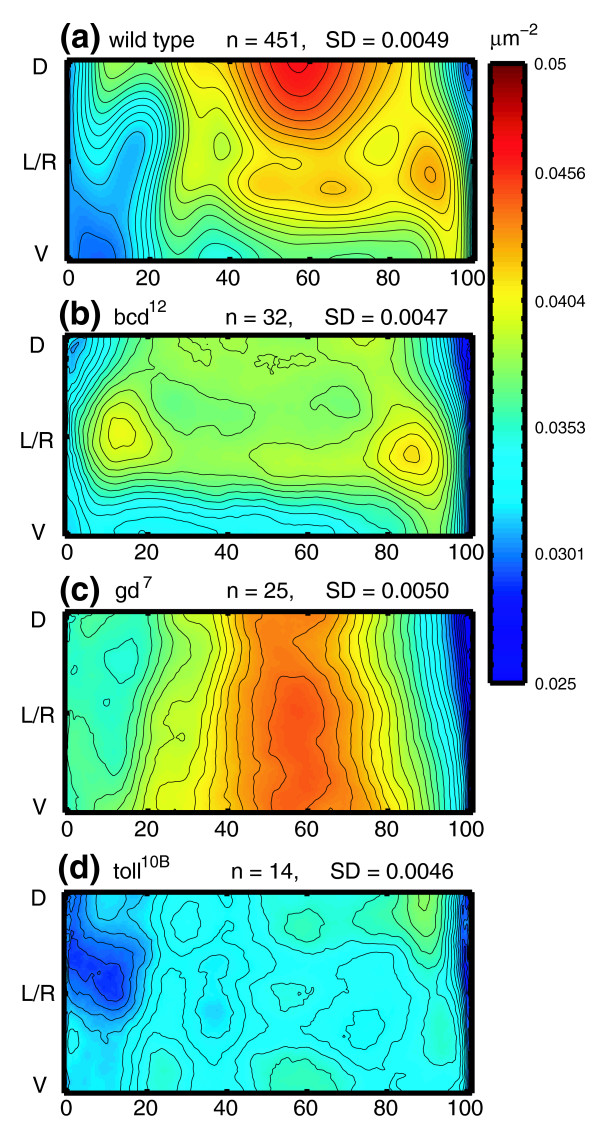
bcd, gd, and Tl regulate nuclear density patterns along both major body axes. Cylindrical projections of nuclear density patterns in (a) wild-type, (b) bcd12 mutant, (c) gd7 mutant, and (d) Tl10B mutant embryos. To reduce noise, information from the left and right sides of each embryo was averaged. All embryos were from stages 5:25-100%. Axes and isodensity contours are as described in Figure 1. All three mutants exhibit changes in the pattern of density along both body axes. Note that while it appears that the total number of nuclei in Tl10B mutants is less than in the wild-type embryos, this reflects a difference between fly strains and not an effect of the Tl gene as there is no statistically significant difference between the average number of nuclei in Tl10B mutants versus their wild-type-like siblings, which are derived from Tl10B hetrozygous mothers.